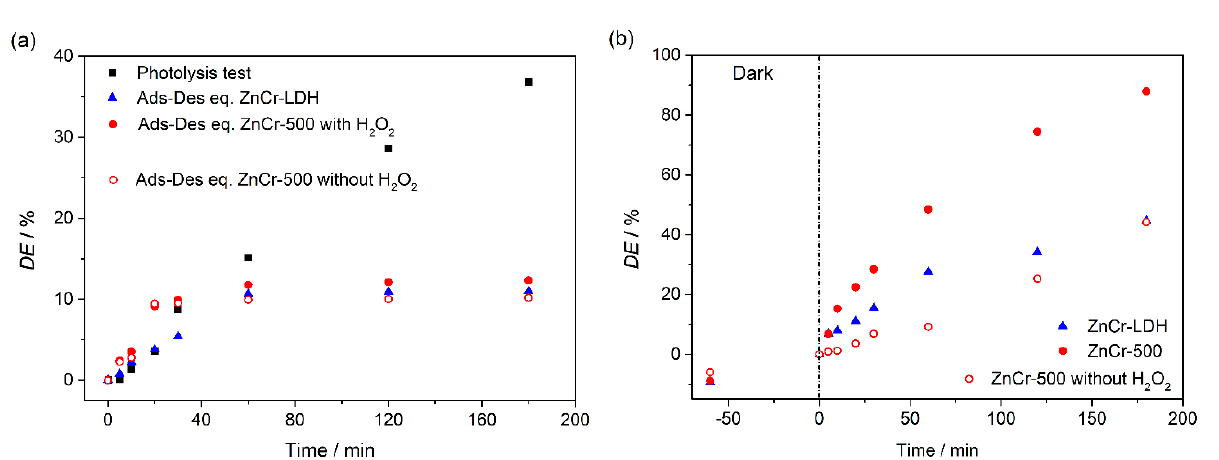
Figure 8. ( a ) Photolysis and adsorption-desorption equilibrium tests, and ( b ) photocatalysis activity tests, for ZnCr-LDH and ZnCr-500 samples.